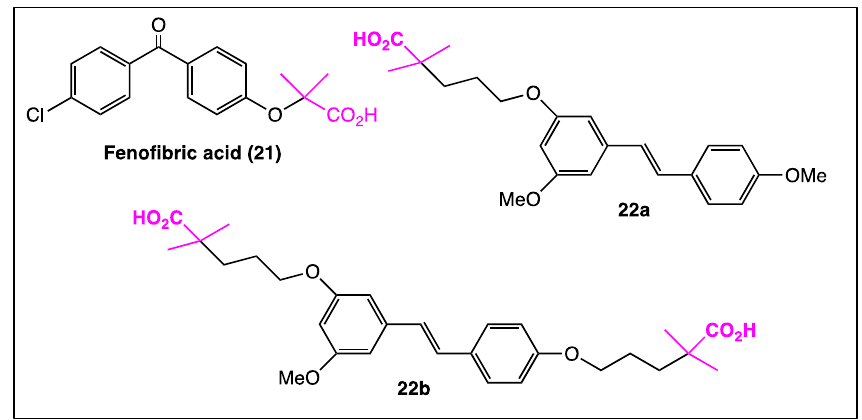
Figure 11 . Structure of fenofibric acid ( 21 ) and hybrid compounds 22a – b. Figure 11. Structure of fenofibric acid ( 21 ) and hybrid compounds 22a – b .